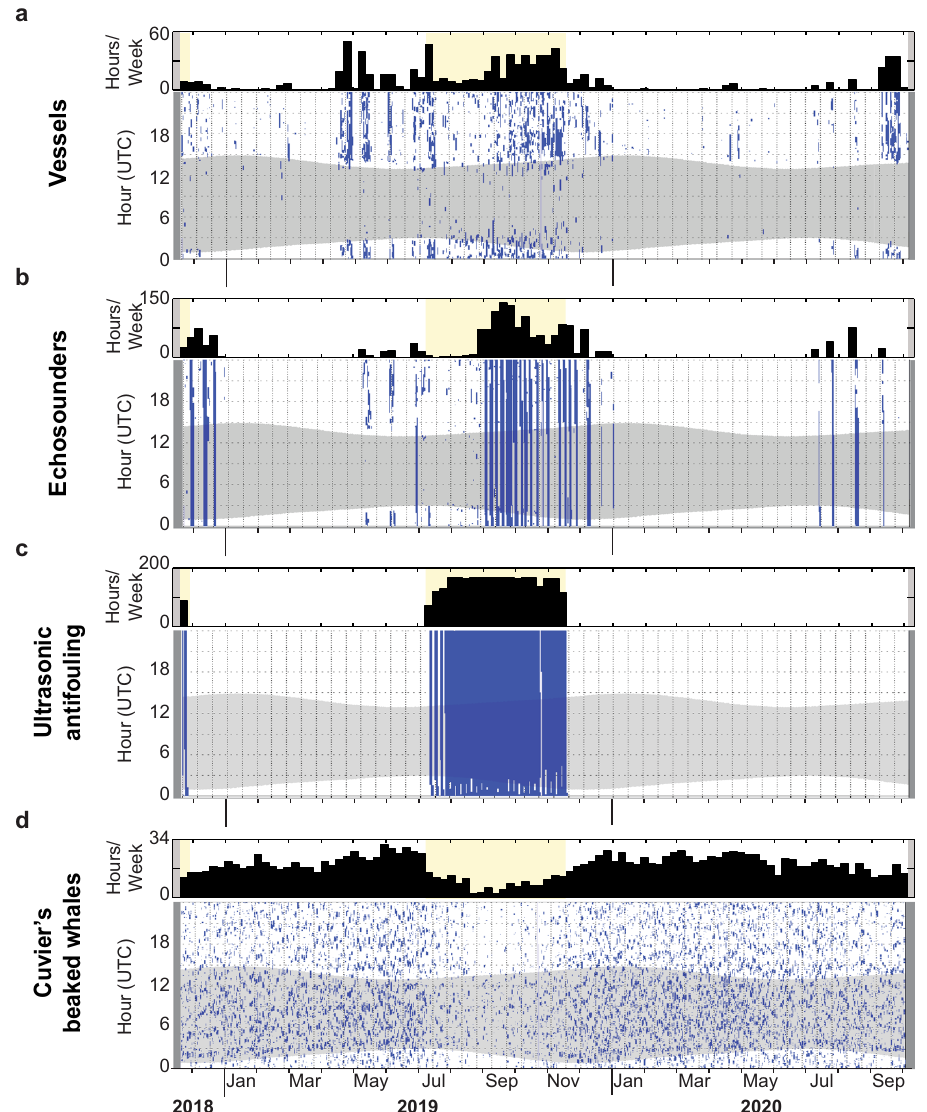
Fig. 3 Acoustic detections. Weekly (black bars) and daily (blue dots) acoustic presence of a motorized vessel noise, b shipboard echosounders, c ultrasonic antifouling (UA) systems, and d Cuvier ’ s beaked whale echolocation clicks at the recording site in Bahía Norte from November 19, 2018 to October 3, 2020. Weekly plots show the number of hours of acoustic presence each week. Daily plots show acoustic presence in 1-min bins and the gray hourglass shading denotes nighttime. Gray vertical shading at the start and end of all plots denotes absence of recording effort. Yellow shading across all weekly plots in November 2018 and from July to November 2019 indicates the weeks with UA signal occurrence. A brief ~27 h effort gap in October 2019 corresponds to the time period used to refurbish the sea fl oor-mounted acoustic